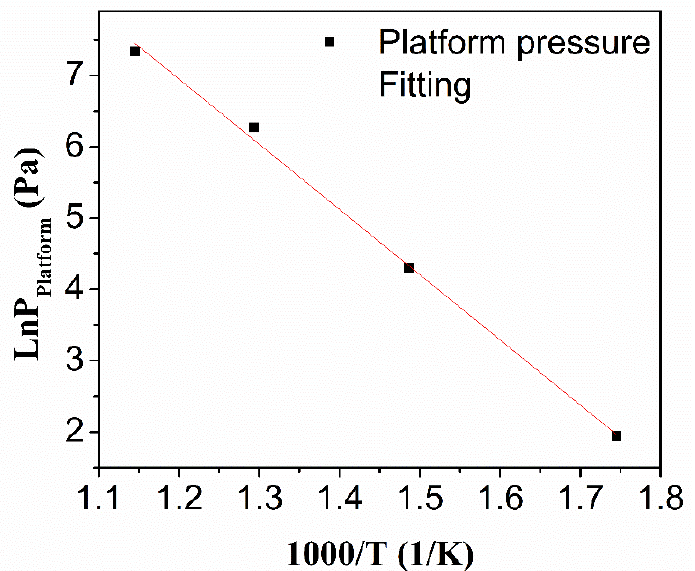
Figure 3. Van ’t Hoff curve illustrating the relationship between plateau pressure and tempera- ture.